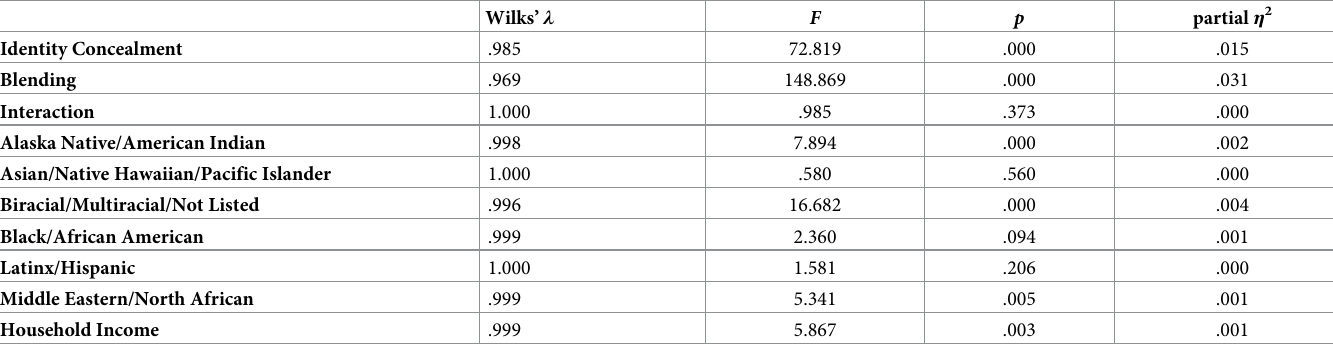
Table 3. MANCOVA